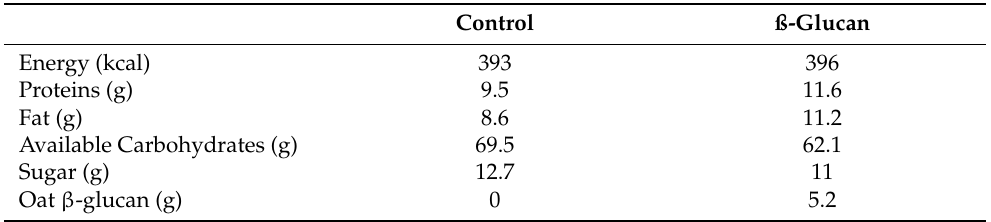
Table 1. Nutritional composition of the breakfasts used in the study. Control ß-Glucan Energy (kcal) 393 396 Proteins (g) 9.5 11.6 Fat (g) 8.6 11.2 Available Carbohydrates (g) 69.5 62.1 Sugar (g) 12.7 11 Oat β -glucan (g) 0